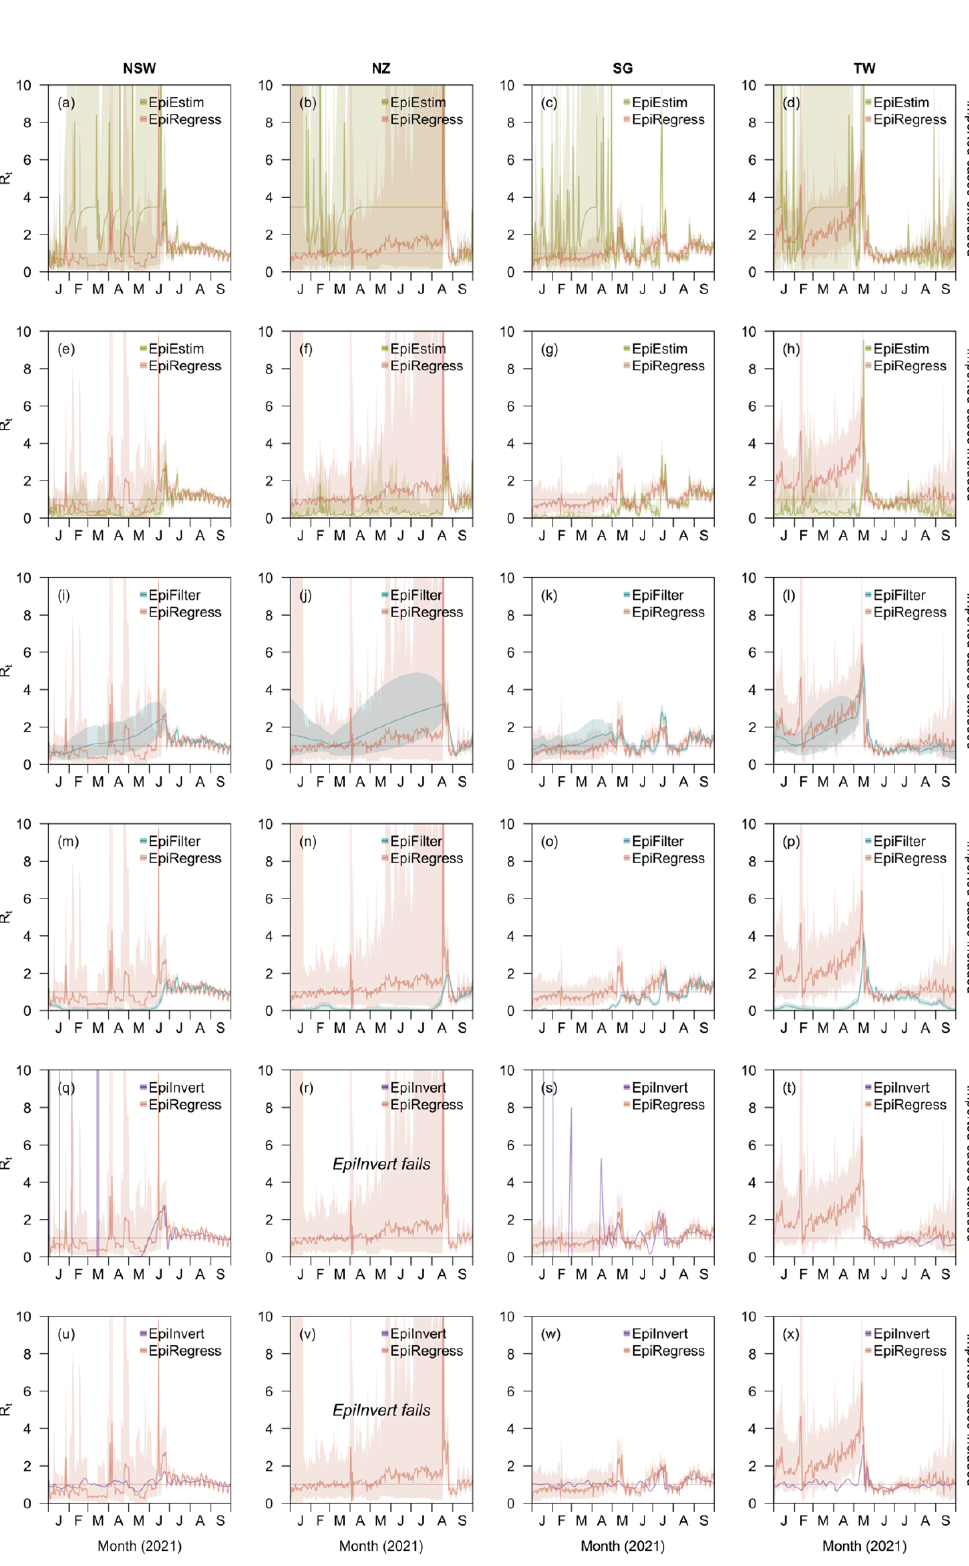
Figure 2. Comparison of EpiRegress against alternative R t estimation methods ( a – d ) EpiEstim with imported cases excluded, ( e – h ) EpiEstim with imported cases included, ( i – l ) EpiFilter with imported cases excluded, ( m – p ) EpiFilter with imported cases included, ( q – t ) EpiInvert with imported cases excluded and ( u – x ) EpiInvert with imported cases included for New South Wales (column 1), New Zealand (column 2), Singapore (column 3), and Taiwan (column 4). EpiInvert failed to perform estimation for New Zealand when imported cases were either included or excluded in the total case counts.